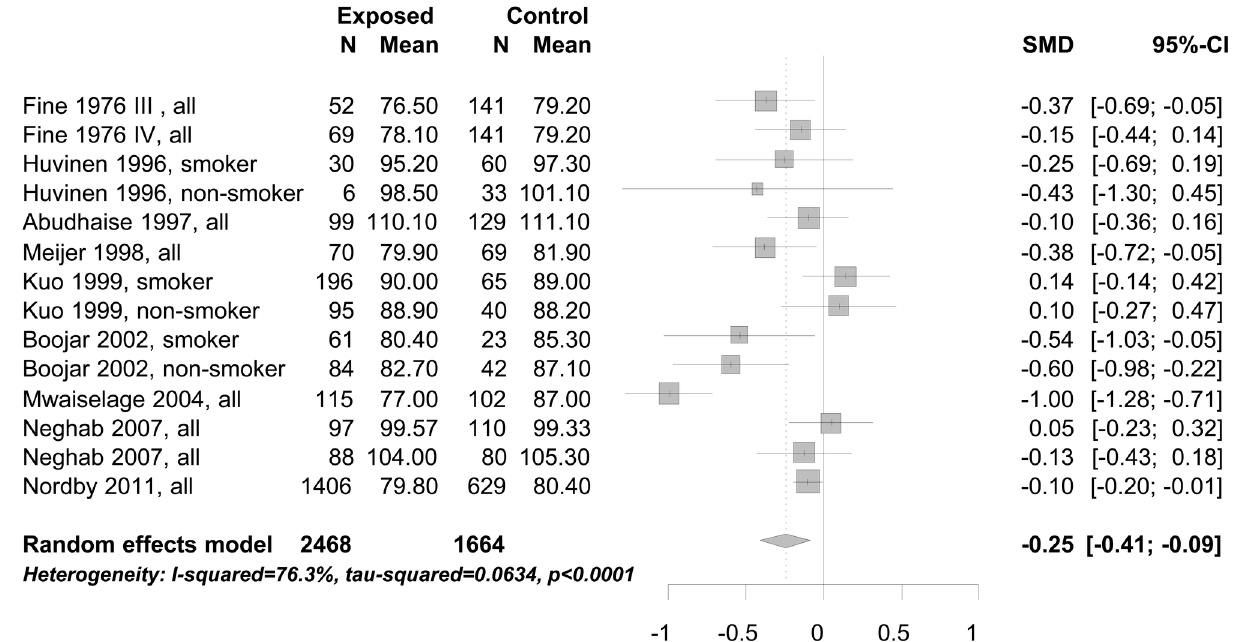
Figure 4. Standardized mean difference of the ratio FEV1/FVC between study participants exposed to bg dust at the work place and low/no exposed participants.